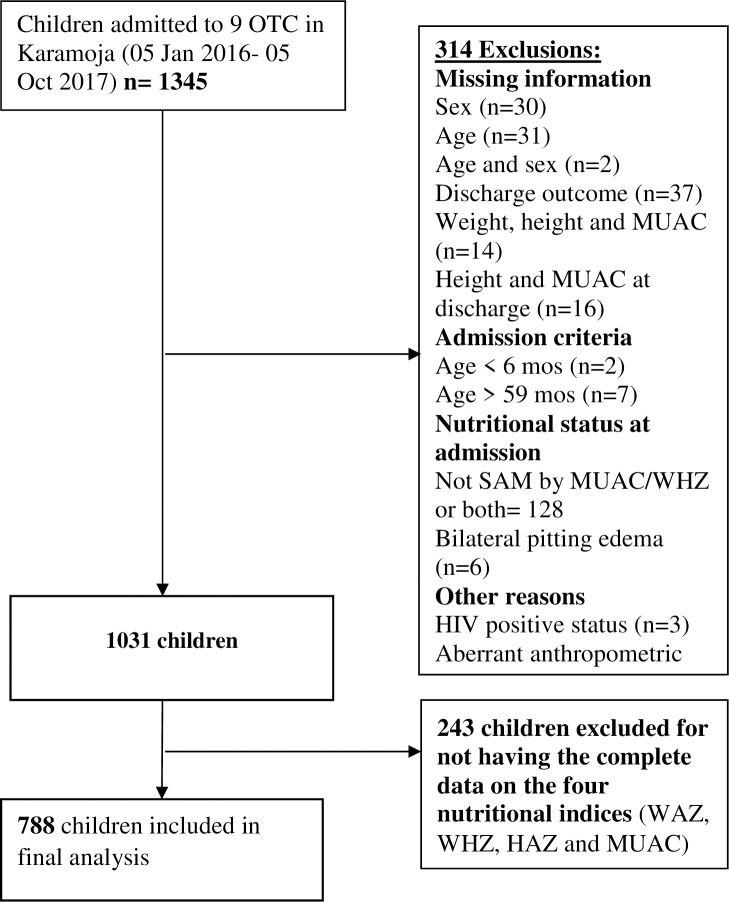
Flow chart showing participant selection among children 6–59 months admitted to OTC in Karamoja.